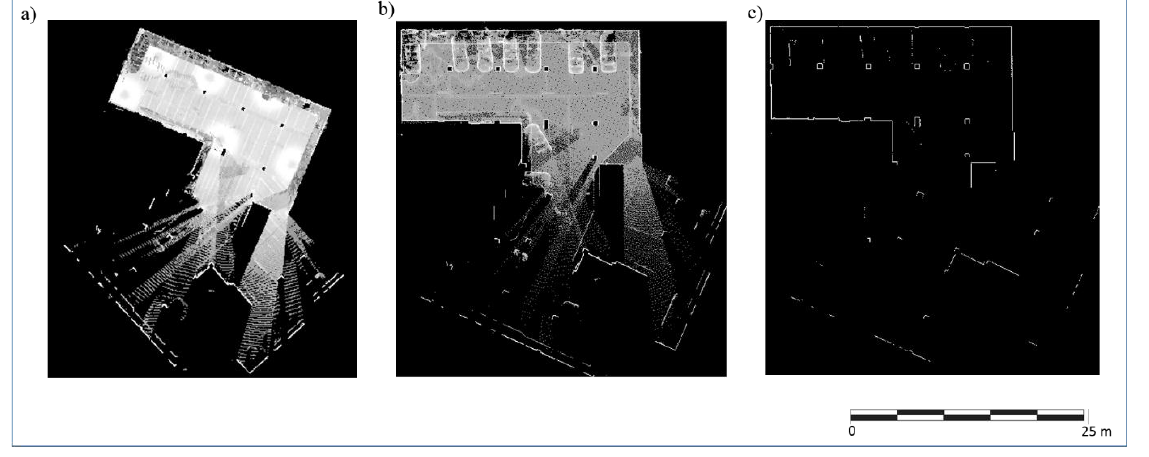
Figure 2. Top view of a point cloud dataset ( a ), its correspondent raster after rotation ( b ), and the final binarized raster ( c ). Brightness and contrast are increased by 20% (b) and 40% (c) to improve its